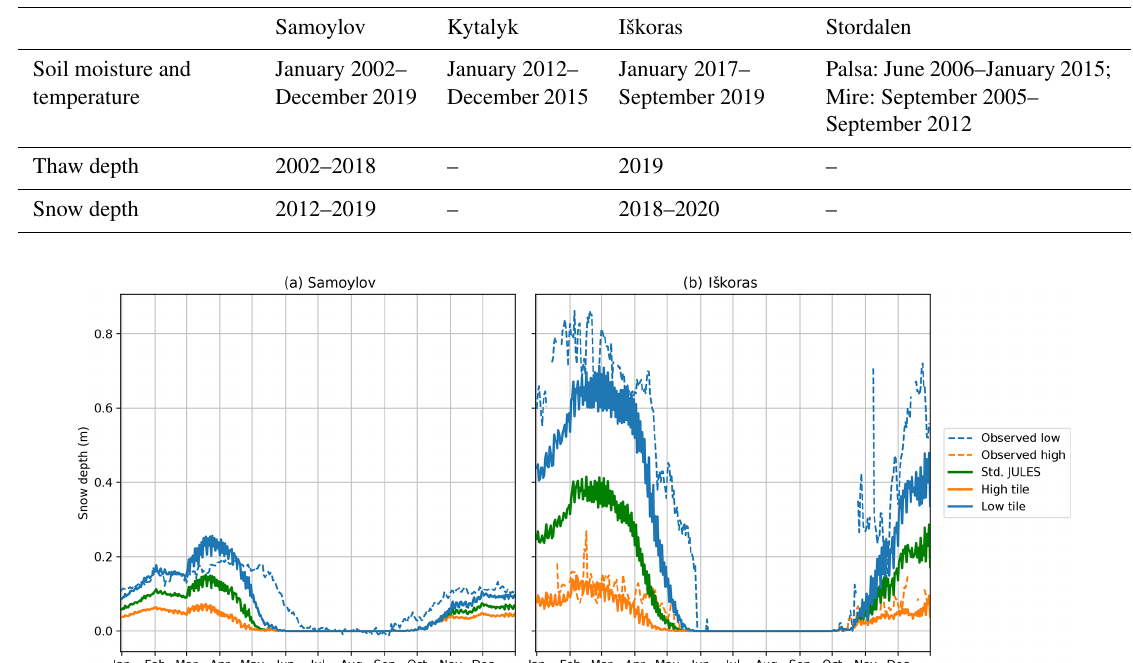
Figure 6. Climatology (2002–2016) of simulated vs. observed snow depths for Samoylov (a) and Iškoras (b) , showing snow redistribution due to microtopography differentiating snow depths. Observed snow depths for Samoylov have been bias corrected using the signal during the snow-free